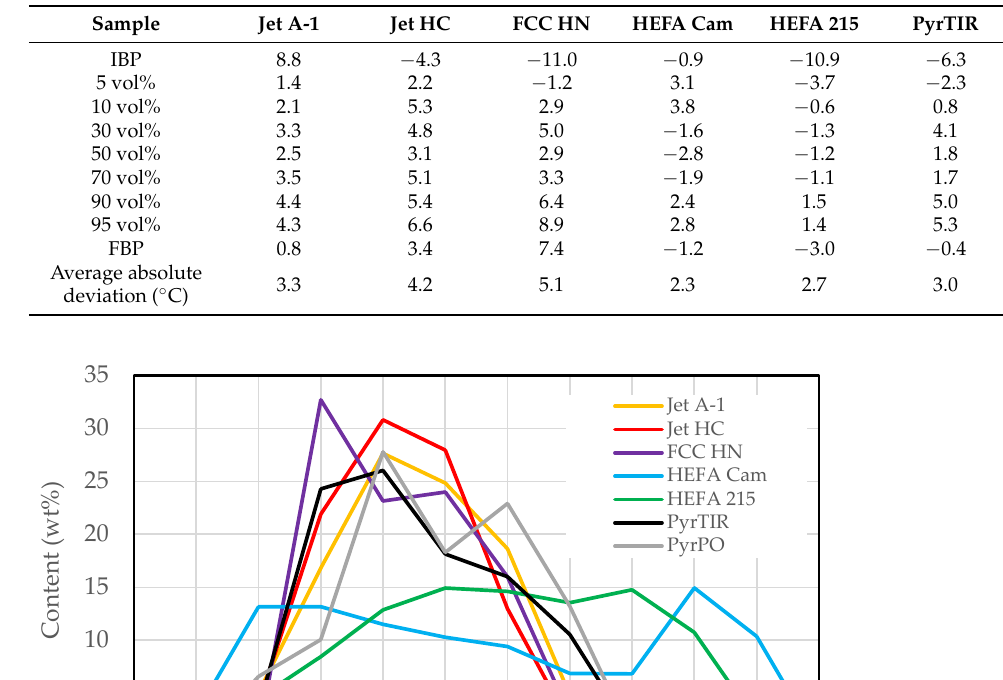
Table 2. Differences between experimental and calculated ASTM D86 results of the samples studied ( ◦ C).